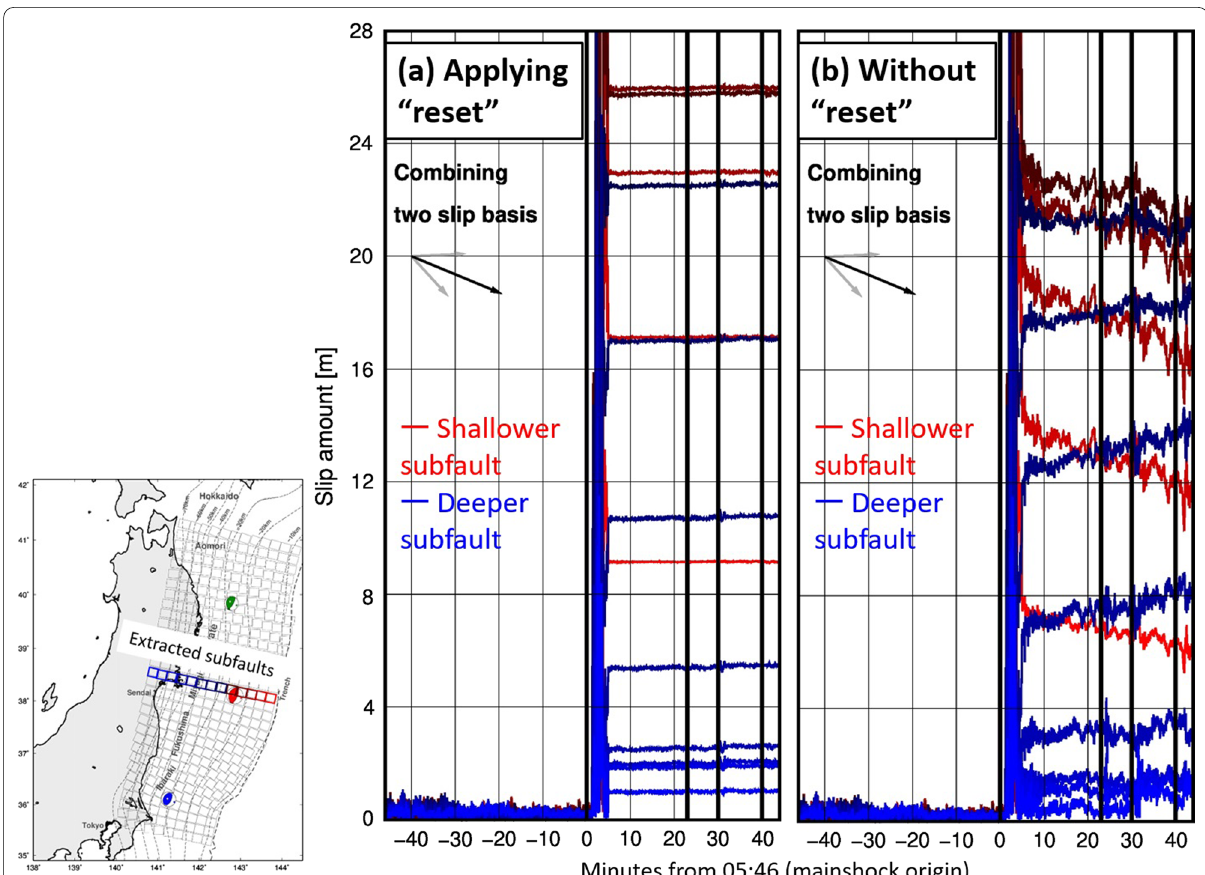
Fig. 4 Comparison of the estimated slip time series with and without “reset after coseismic change.” The figure on the left shows the results of this analysis ( a ), while that on the right side shows the results without “reset” and switch of smoothing strength ( b ). Both figures show time series for along dip 13 subfaults crossing the mainshock hypocenter. Red lines represent updip 5 subfaults, and blue lines represent downdip 8 subfaults, respectively. The figures cover the entire analysis period, setting the mainshock origin as zero. Black vertical lines represent the origin times of the mainshock and three major